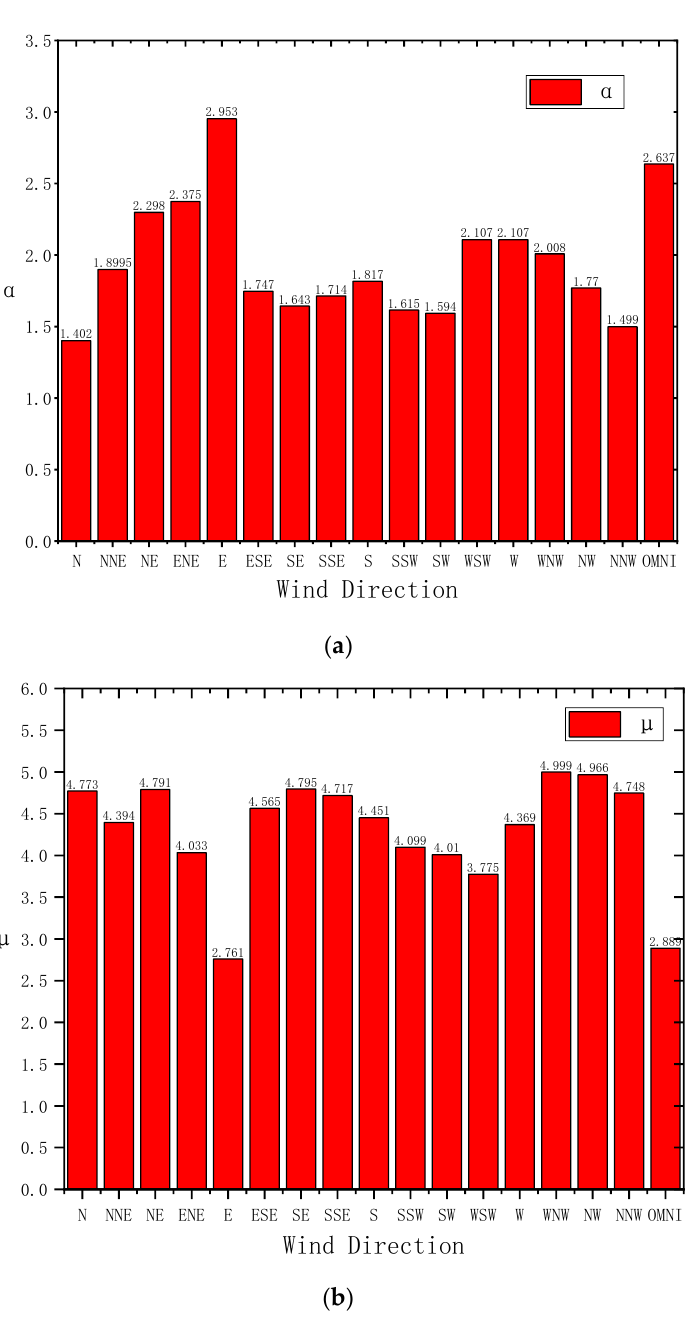
Figure 15 . Gumbel distribution parameter estimation results of wind speed and direction joint distribution.( a )α of Gumbel distribution.( b ) μ of Gumbel distribution.